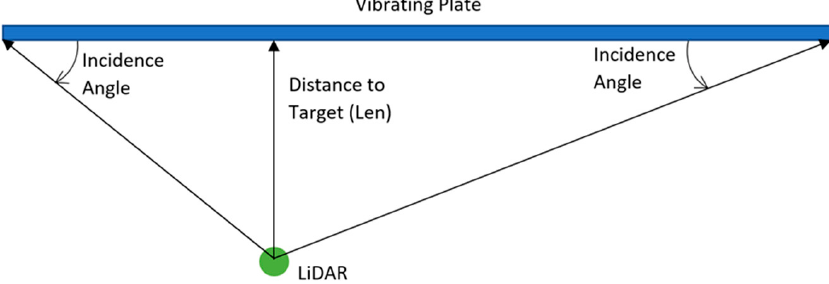
Figure 8. Measurement of the incidence angle.